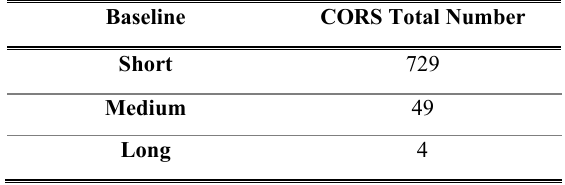
Table 5. Estimated cost based on distribution of CORS network for short, medium and long